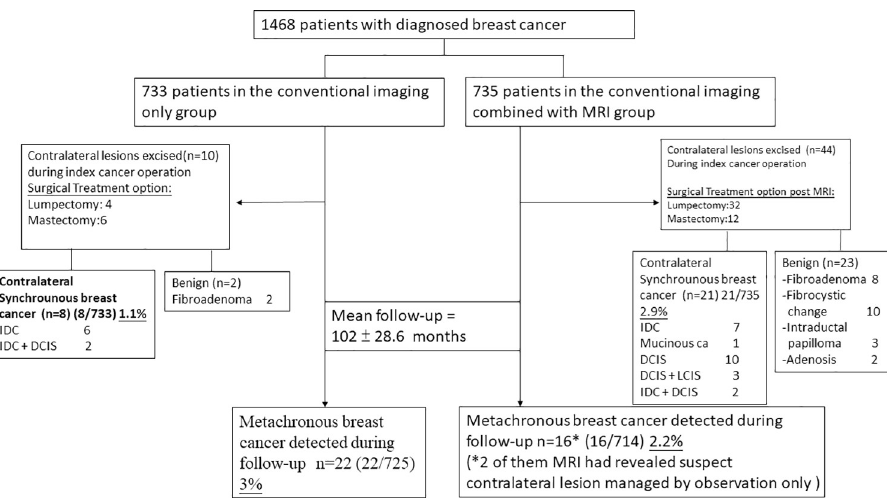
Fig 1. The flowchart presented the current case control comparison study, which enrolled a total of 1468 patients. Group A (n = 733) comprised patients who underwent conventional preoperative imaging (mammography and sonography) and group B (n = 735) comprised patients who received MRI combined with conventional imaging. With the addition of breast MRI to conventional imaging studies, more surgical excisions were performed in contralateral breasts (6% (44/735) versus 1.4% (10/733), P < 0.01), more synchronous contralateral breast cancer detected (2.9% (21/ 735) versus 1.1% (8/733), P = 0.02).